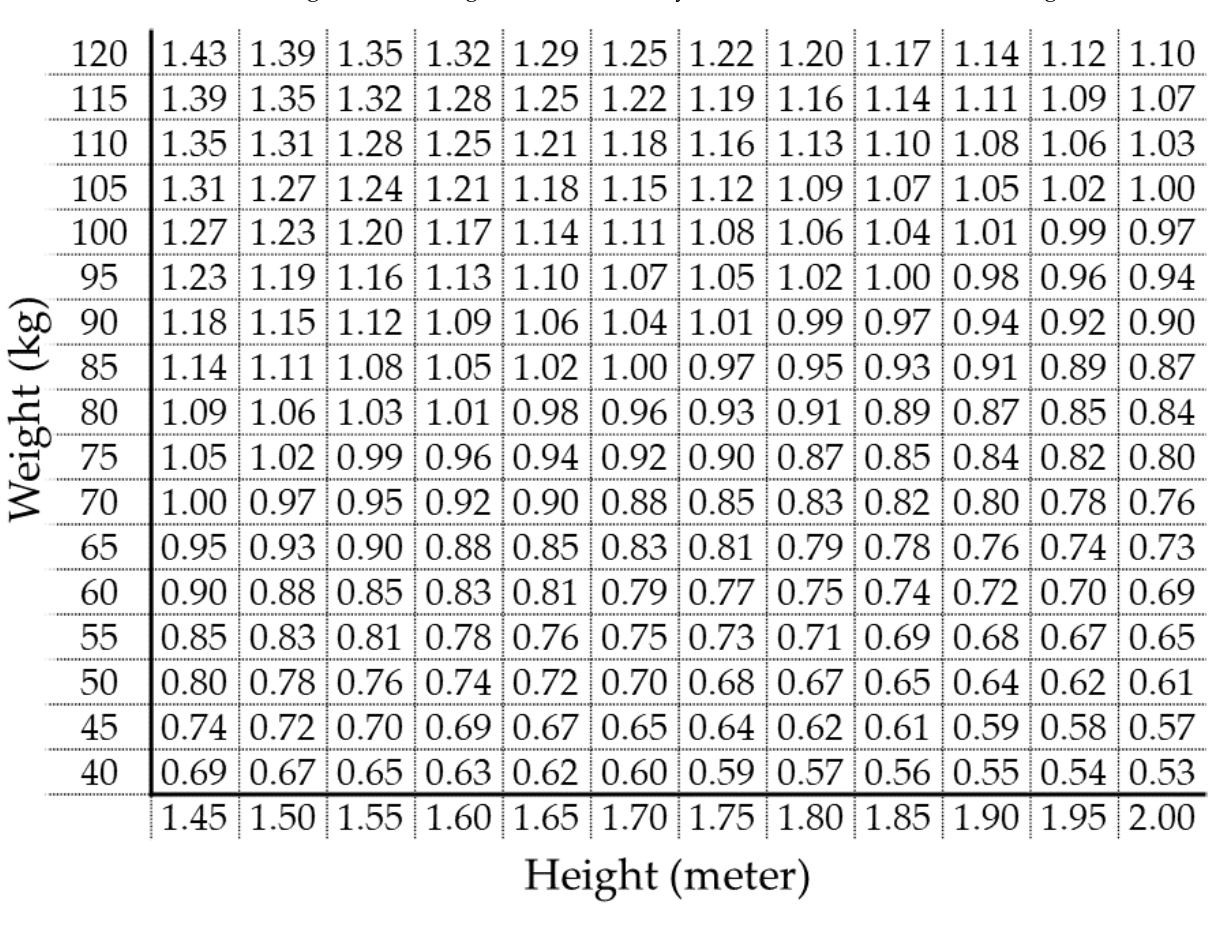
Figure 2. Waist circumference (m) chart for the ABSI cutoff at 0.0801. Colored distribution of waist circumference is shown in Figure 1A. An example of clinical use: If a person 1.70 m in height and 85 kg in weight has a waist circumference of 1.00 or higher, his/her ABSI is estimated to be 0.0801 or higher.